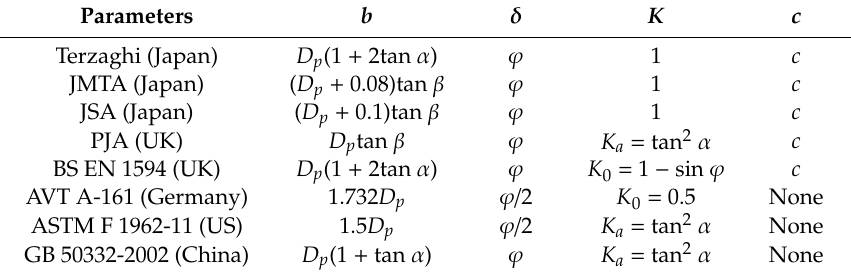
Table 1. Definition of the empirical parameters in Terzaghi’s silo model by different authors [37].